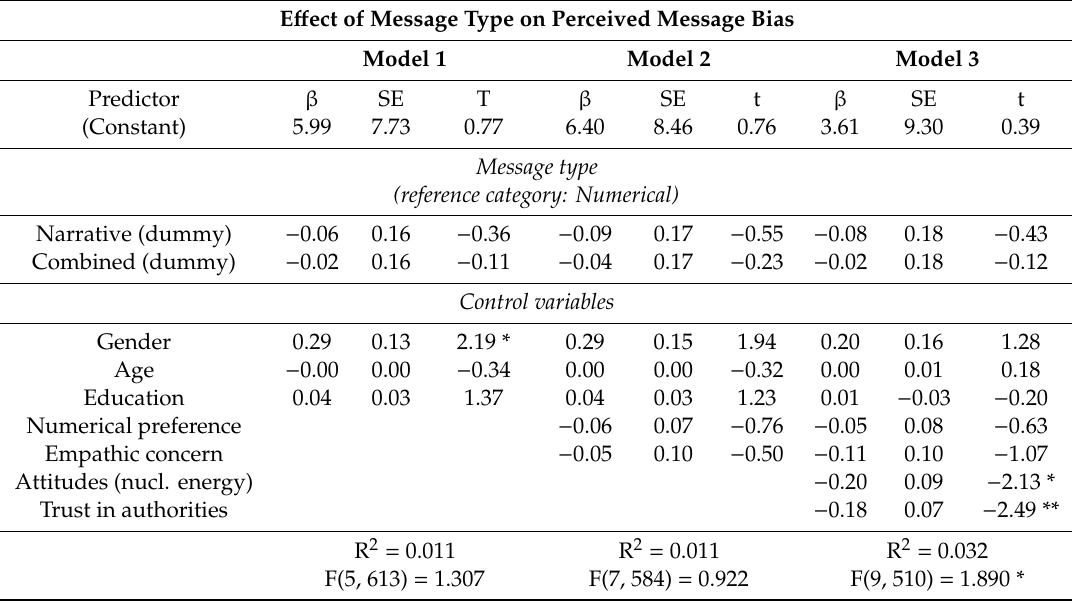
Table 2. E ff ect of message type on perceived message